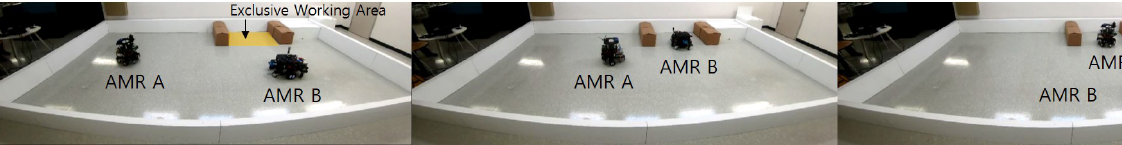
Figure 12. AMR A and B in the exclusive working region under the region